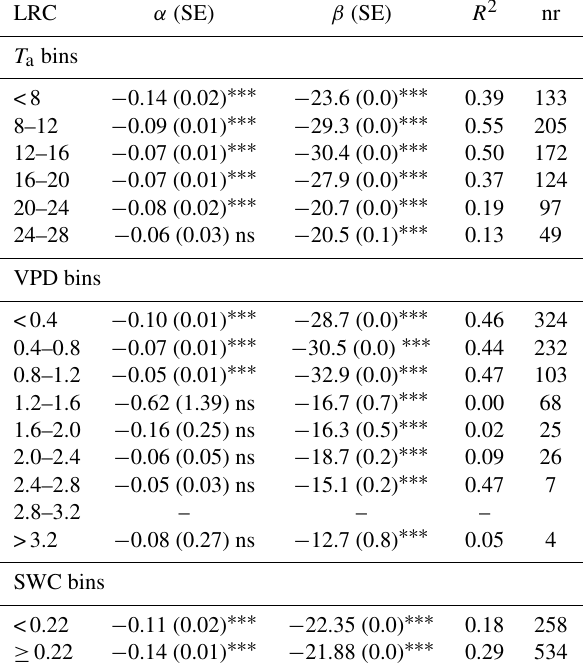
Table 5. Parameters, standard errors and/or the coefficient of deter- mination ( R 2 ) of the temperature-response function after Lloyd and Taylor (1994) between daily means of u ∗ -filtered night-time NEE and air temperature ( T a ) for subsets of data. R ref : basal